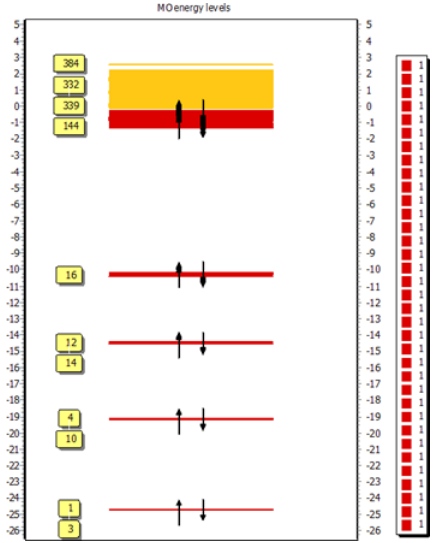
Figure 18. MO energy-level diagram of the CT complex [(FXN)(PA)]. The HOMO – LUMO and HOMO-1 – LUMO gaps (∆E) for [(FXN)(PA)] were 3.646 and 3.768 eV, respectively [44]. Based on these DFT results, some theoretical molecular parameters related to chemical reactivity in water as solvent are presented in Table 3 [45,46]. Table 3. Theoretical molecular characteristics and components of CT complex [(FXN)(PA)]. Parameters. RB3LYP/ 6-311G++ Minimum SCF energy (a.u.) − 2008.551032 Polarizability (α) (a.u.)